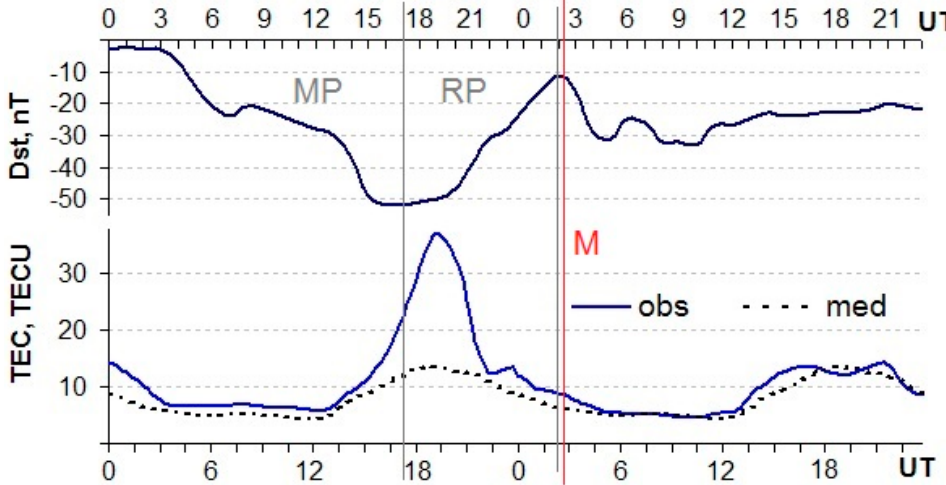
Figure 1. Variations of Dst-index (upper panel) and vTEC (lower panel) during 18–19 February 2020. Observed vTEC (blue curve); vTEC median by 27 previous days (black dotted curve).